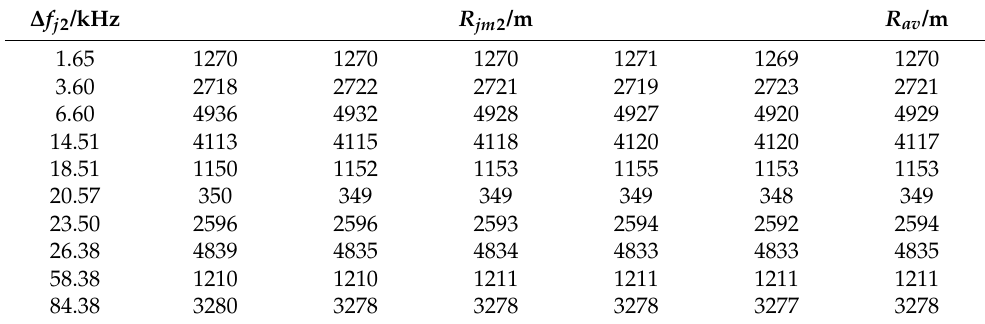
Table 5. Second-order intermodulation signal position under different frequency offset.